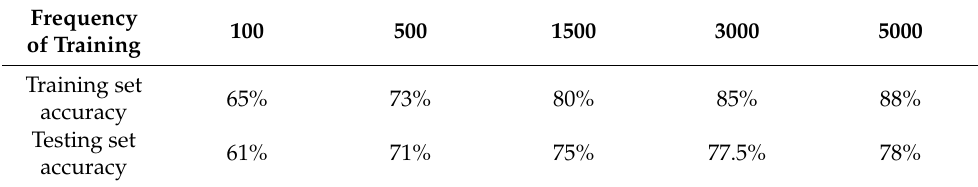
Table 5. Accuracy of SDAE classifier with different training